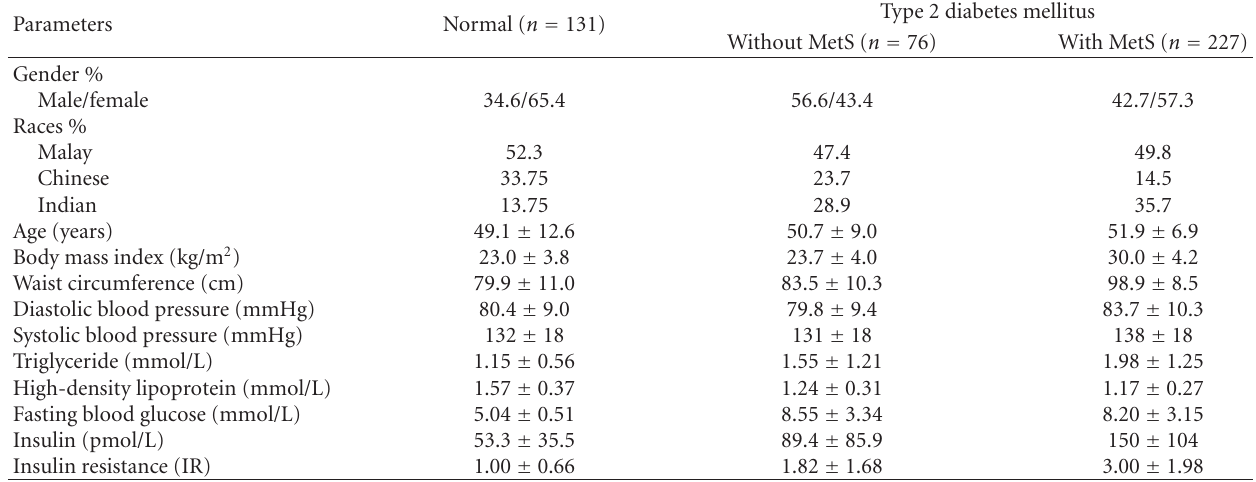
Table 1: Demographic and biochemical parameters among normal and type 2 diabetes mellitus with or without metabolic syndrome subjects.